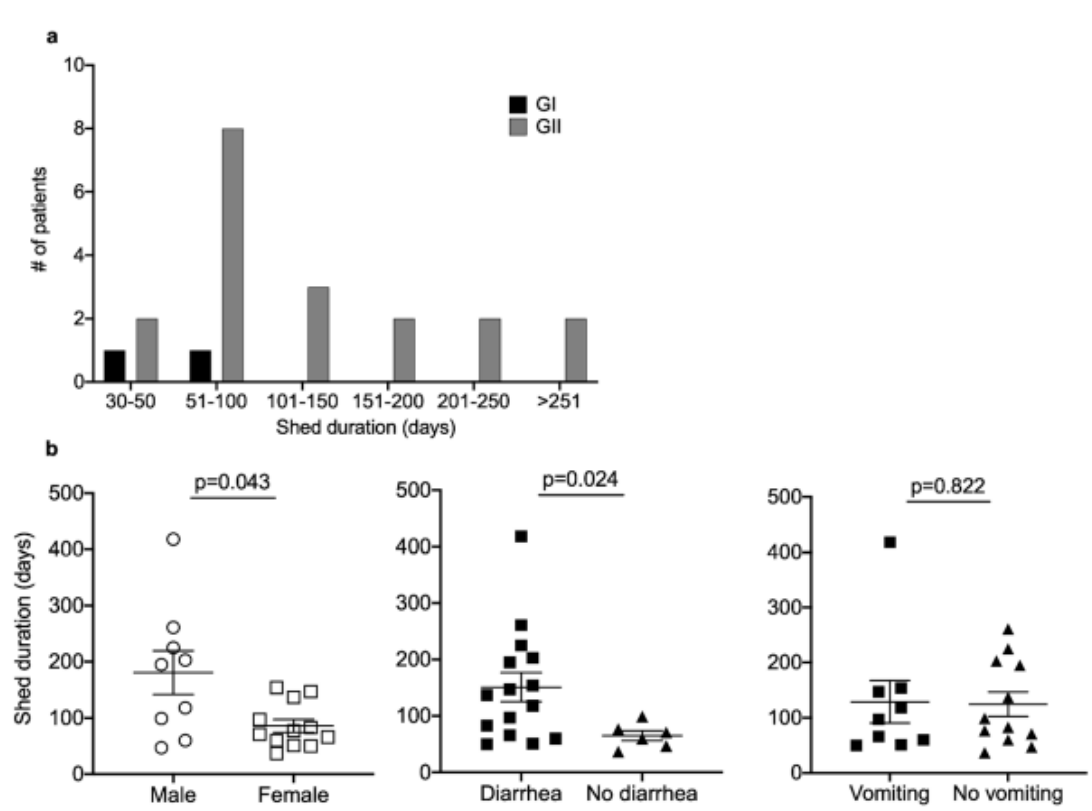
Figure 3. A subset of 21 infections was characterized by chronic virus shedding for >30 days. The number of patients and duration of virus shedding ( a ) varied for GI and GII infections, but most patients shed for <100 days. ( b ) An exploratory analysis of variables associated with longer shedding implicated male sex and the presence of diarrheal symptoms, but not vomiting, as significant. Statistical difference between groups was determined by the Mann–Whitney U-test, with a 2-sided p -value of <0.05 denoting significance.